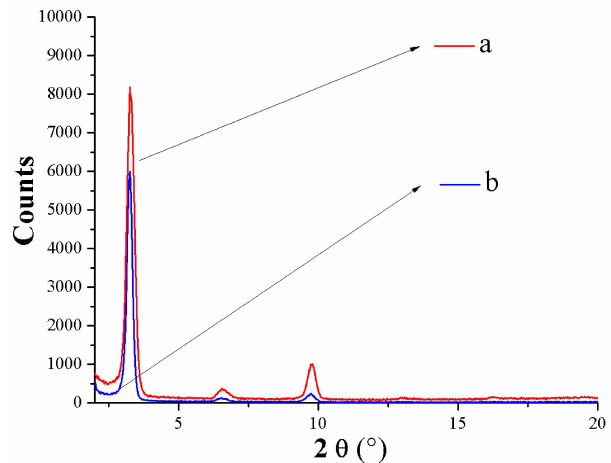
Figure 15. Small-angle X-ray scattering of a 10-layer Langmuir–Blodgett film of 2b complex: a—four days and b—12 months, after